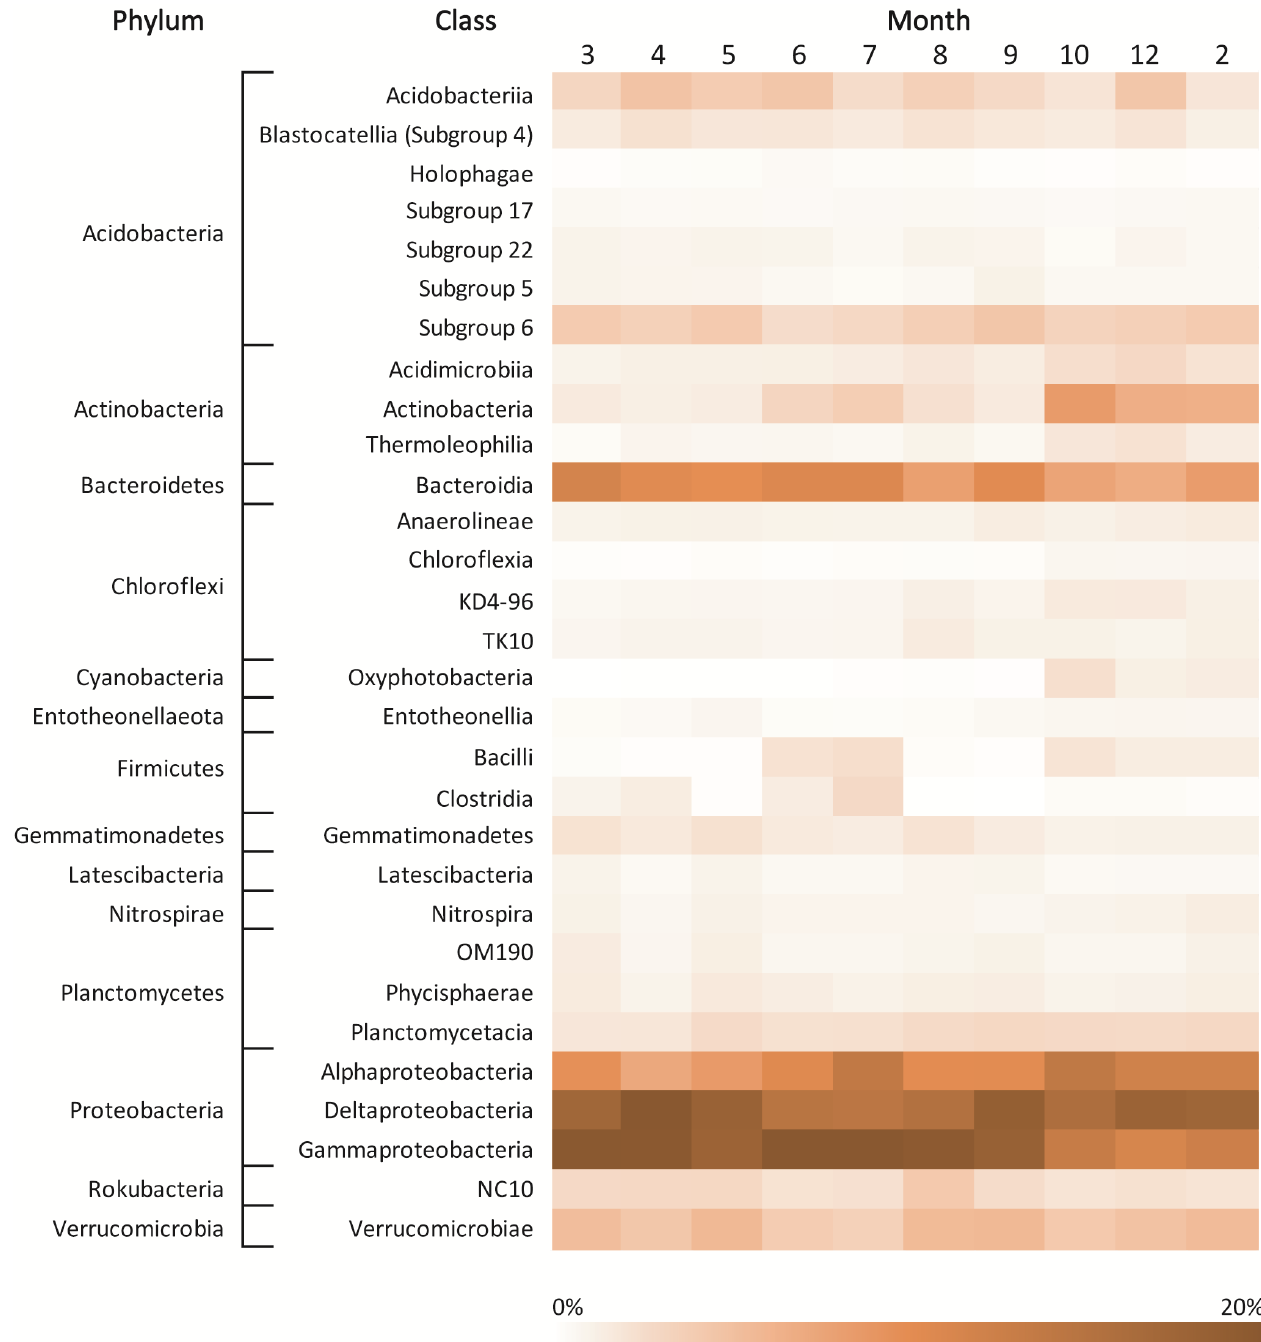
Figure 4. Relative abundances of different classes in total bacterial communities of the upper organic soil horizon throughout the season.